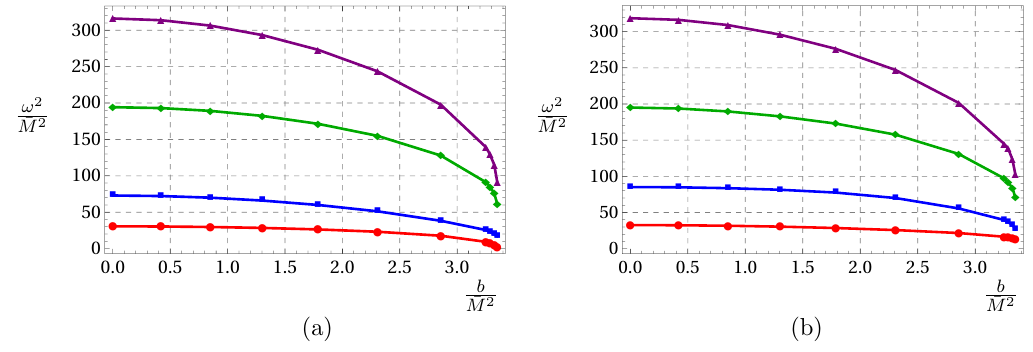
Figure 15 . Meson spectrum ! 2 for the (cid:31) (a) and (cid:30) (b) perturbations as a function of b= (cid:22) M 2 . In (cid:22) M 2 both cases the temperature is (cid:12)xed at T= (cid:22) M = 0 : 65. The di(cid:11)erent colors correspond to di(cid:11)erent quantum numbers ( n; l ) of the mesons, being from bottom to top red (0 ; 0), blue (1 ; 0), green (0 ; 2), and purple (1 ;